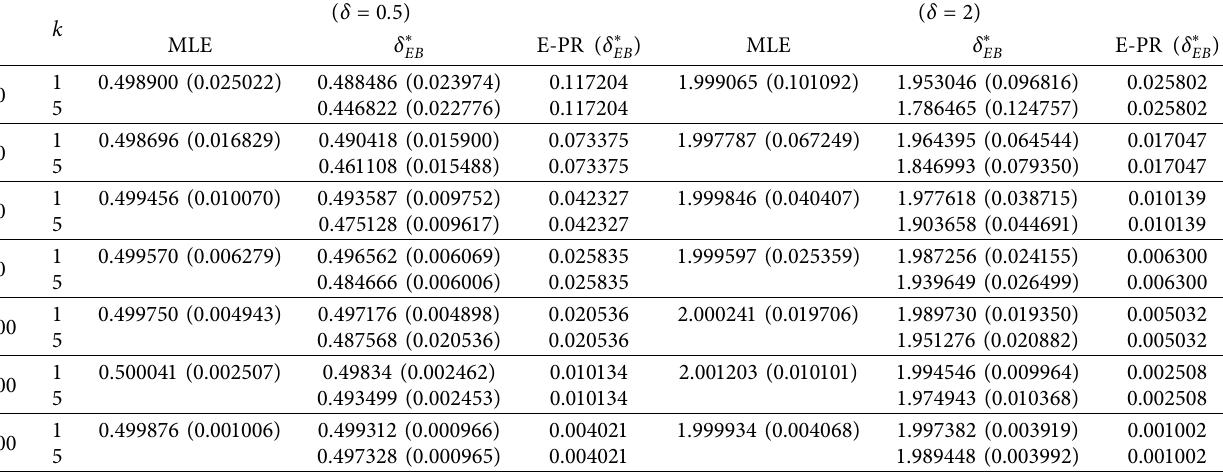
Table 5: E-B and E-PR estimates of PPLF.